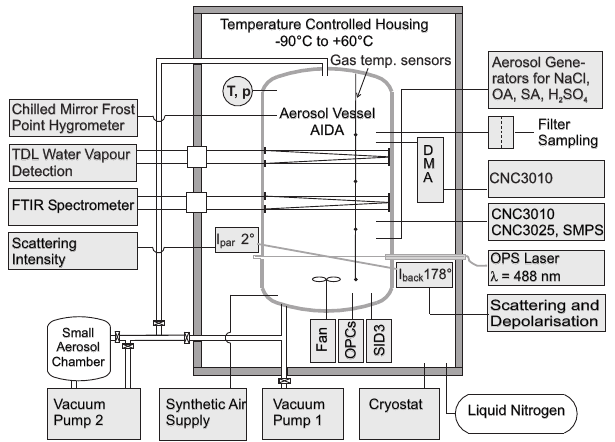
Fig. 2. Schematic cross section of the AIDA facility with the main instrumentation for the ice nucleation experiments in the ternary NaCl/OA/H 2 O and H 2 SO 4 /OA/H 2 O systems.